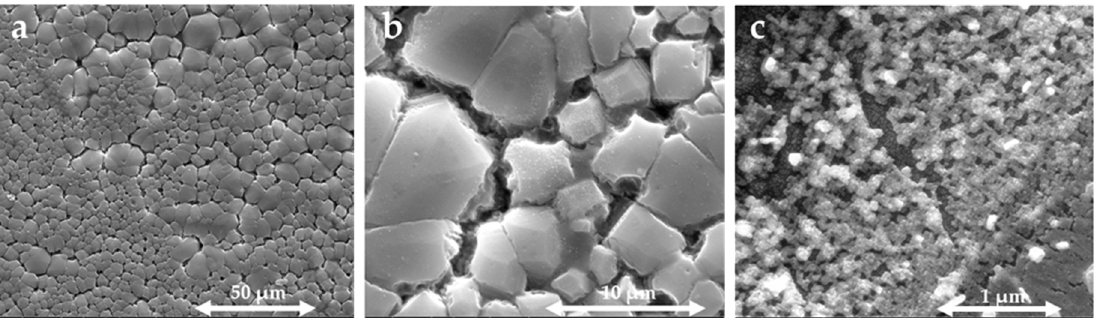
Figure 4. The SEM micrographs of DIPAC fi lm at di ff erent enlargement scales ( a ) 50, ( b ) 10, and ( c ) 1 µm.